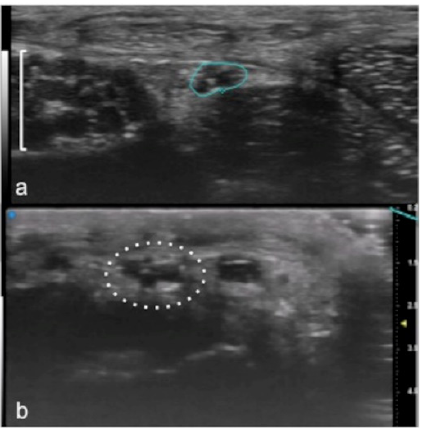
Figure 9. Visualization of small peripheral nerves using UHFUS. Recurrent branch (line) of the median nerve (square parenthesis) at the level of the thenar eminence in ( a ). Digital branch (dot circle) of the median nerve at the level of the finger in ( b ).